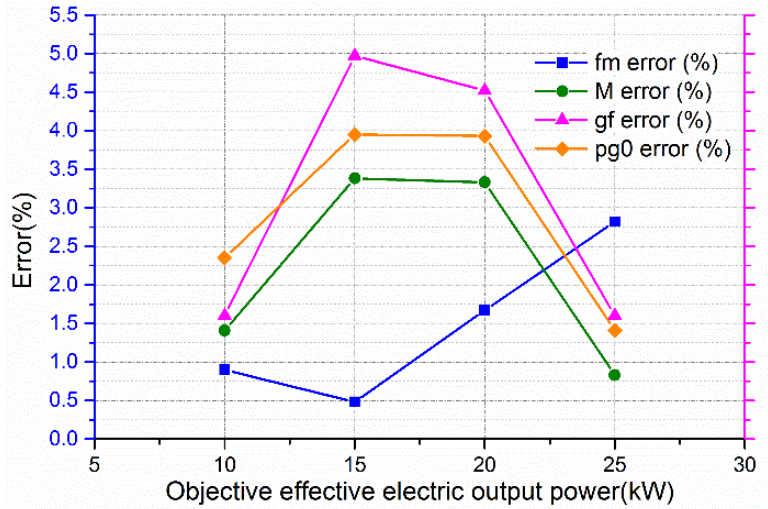
Figure 18. Errors of the key operational parameters for various power demands.